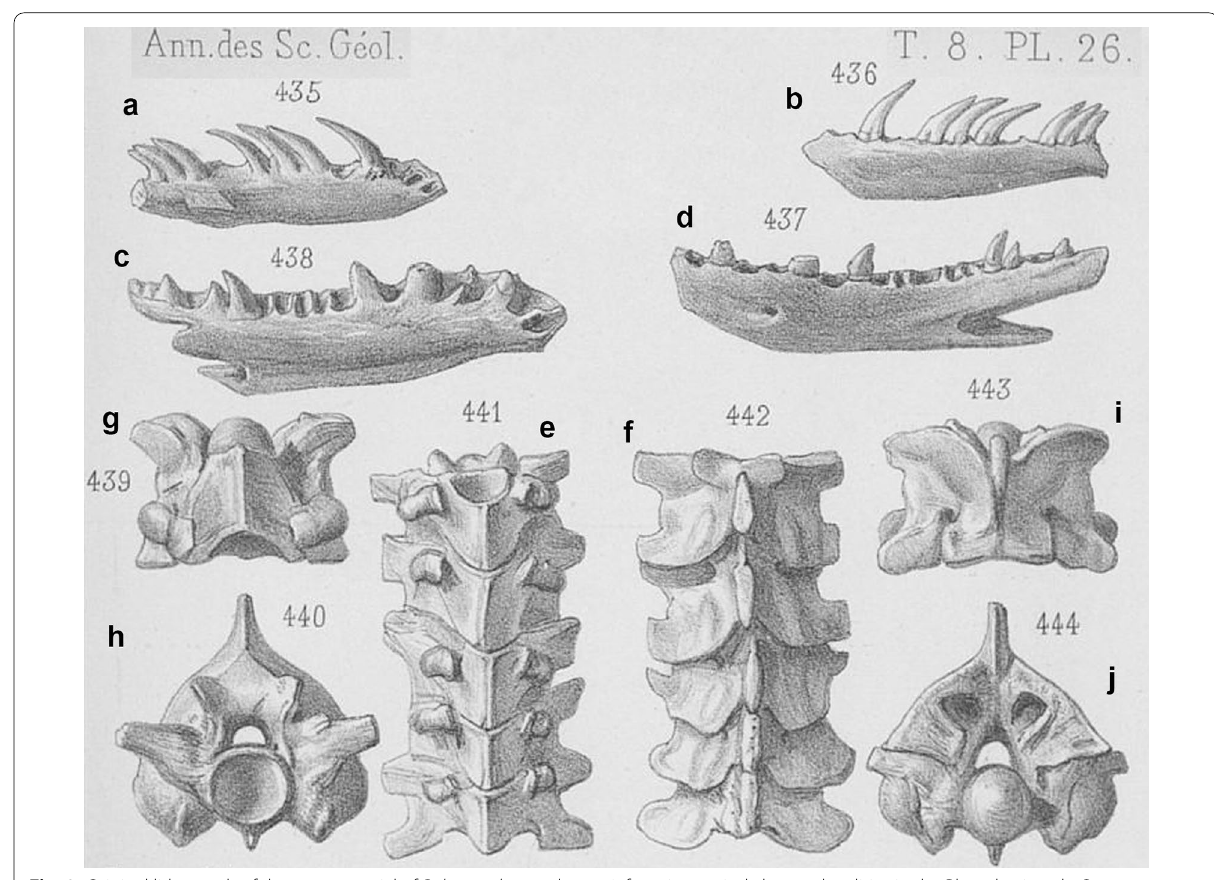
Fig. 3 Original lithograph of the type material of Palaeopython cadurcensis from imprecisely known localities in the Phosphorites du Quercy: a , b paralectotype left maxilla MNHN.F QU16321 in medial ( a ) and labial ( b ) views; c , d paralectotype right dentary MNHN.F QU16317 in medial ( c ) and labial ( d ) views; e , f lectotype (herein designated) five articulated trunk vertebrae MNHN.F QU16318 in ventral ( e ) and dorsal ( f ) views; g–j paralectotype (currently non-located) trunk vertebra in ventral ( g ), anterior ( h ), dorsal ( i ), and posterior ( j ) views. Note that the figures represent the reverse images of the respective specimens, as is the common practice in lithography. Modified from plate 26 of Filhol (1877a)—numbers 435–444 corresponds to the original figure numbering of that publication. The same exactly lithograph appeared in Filhol (1877b,